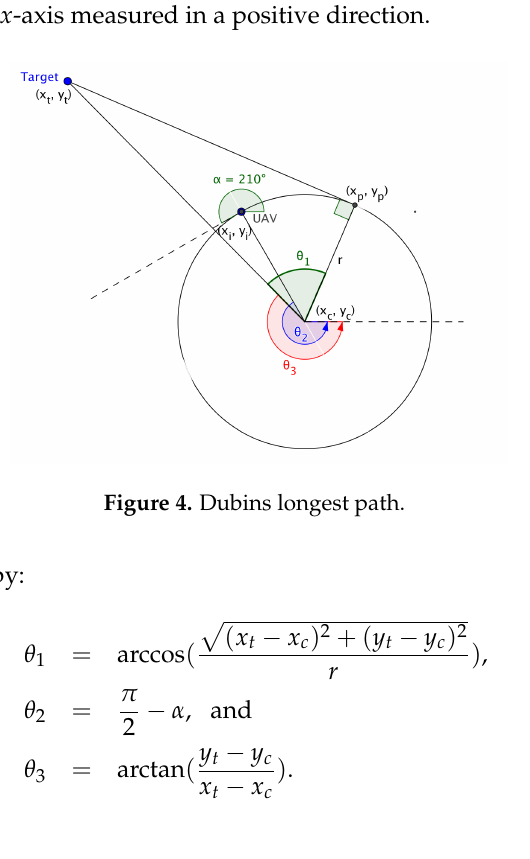
the target and the positive x -axis measured in a positive direction.